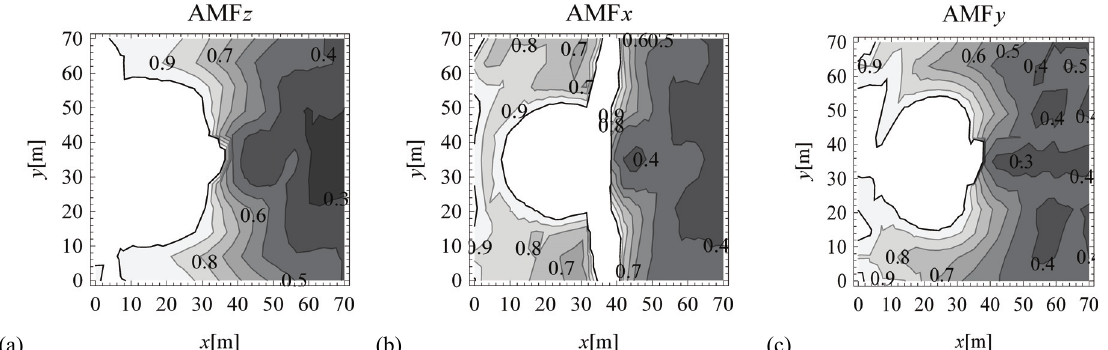
Fig. 9. AMF for the analyzed domain with the three displacement components for the points located on the ground surface, r = 2 m; plot range: 0 < AMF < 1;